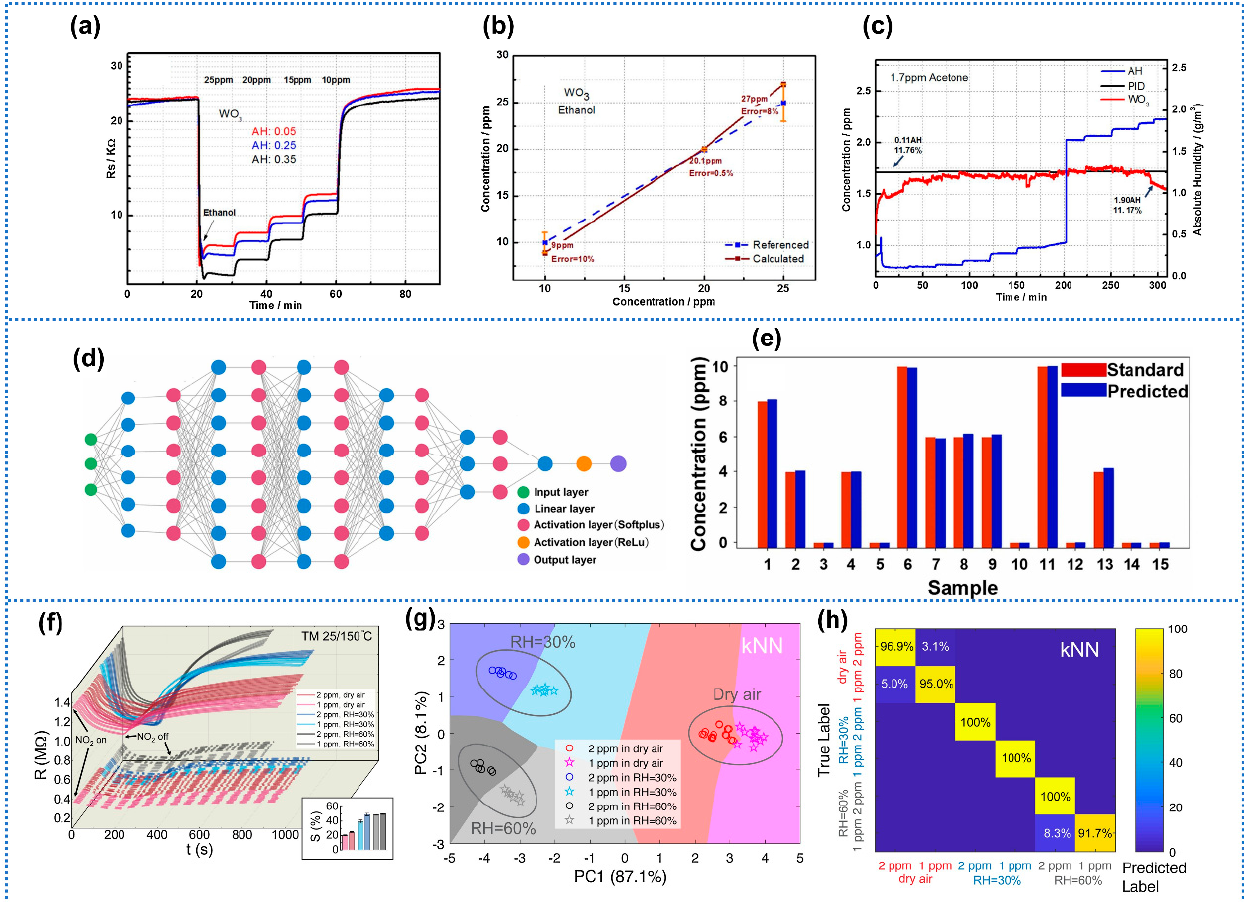
Figure 10. (a ) Transient resistance of WO 3 sensor to ethanol with different concentrations and humidity conditions. ( b ) Calculation of concentration of WO 3 sensor in response to ethanol. ( c ) Comparison of PID sensor and compensation model for WO 3 sensor. Reprinted with permission from Ref. [121]. Copyright 2021, Elsevier. ( d ) Schematic illustration of deep BP neural network model structure with 14 layers. ( e ) The predicted outputs based on Adam optimizer with Softplus activation function. Reprinted with permission from Ref. [122]. Copyright 2022, Elsevier. ( f ) Repeated measurements of sensor responses of six sets of ([NO 2 ], [RH]) paired groups. The inset shows the responsivity of each group. ( g ) PCA scores and classification with kNN. ( h ) Confusion matrix of the classification system. Reprinted with permission from Ref. [49]. Copyright 2020, Elsevier.